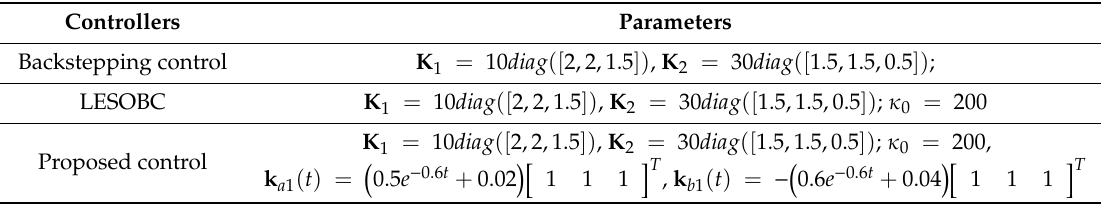
Table 2. Parameters of the three controllers.